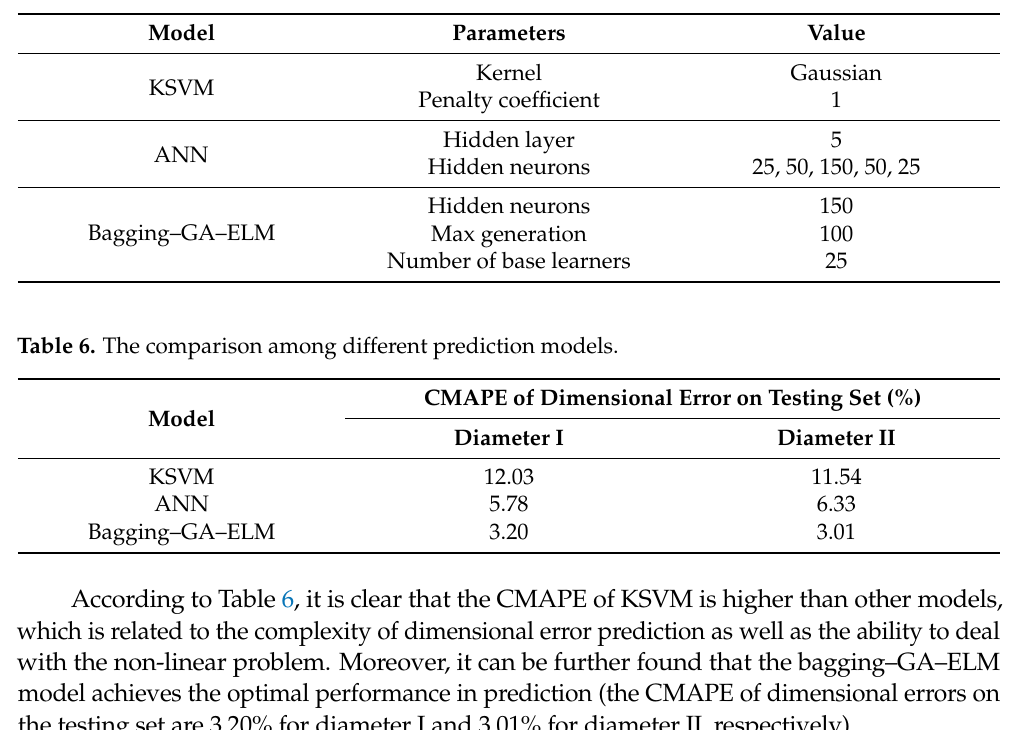
Table 5. The parameters of different prediction models.